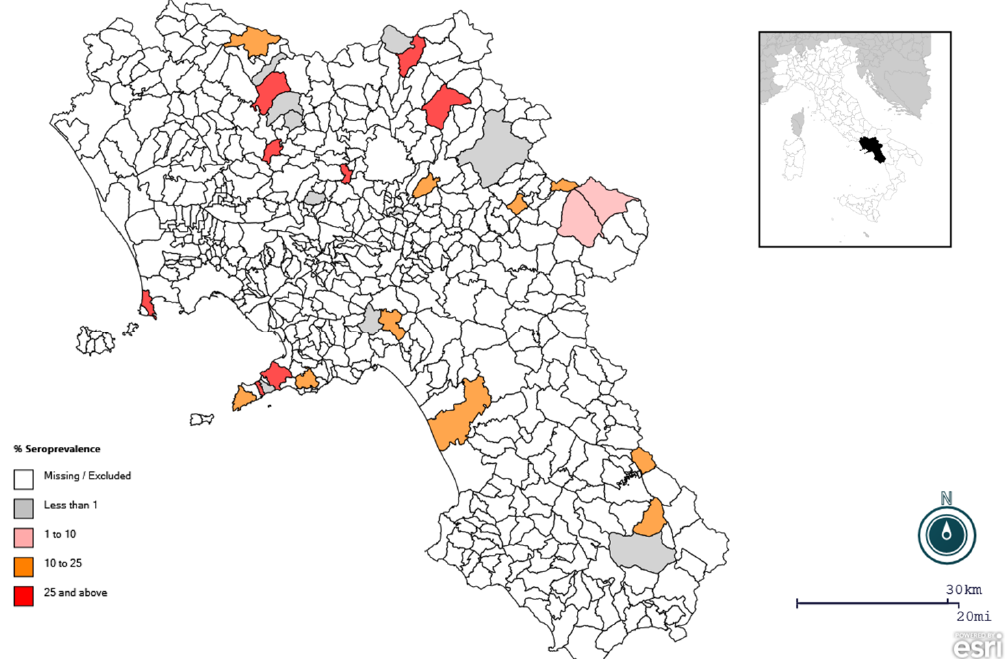
Figure 1. Spatial distribution of positive farms for PEDV in the pig population in the Campania region, southern Italy. A large proportion of the sampled districts had seroprevalence between 10% and 25% or higher.